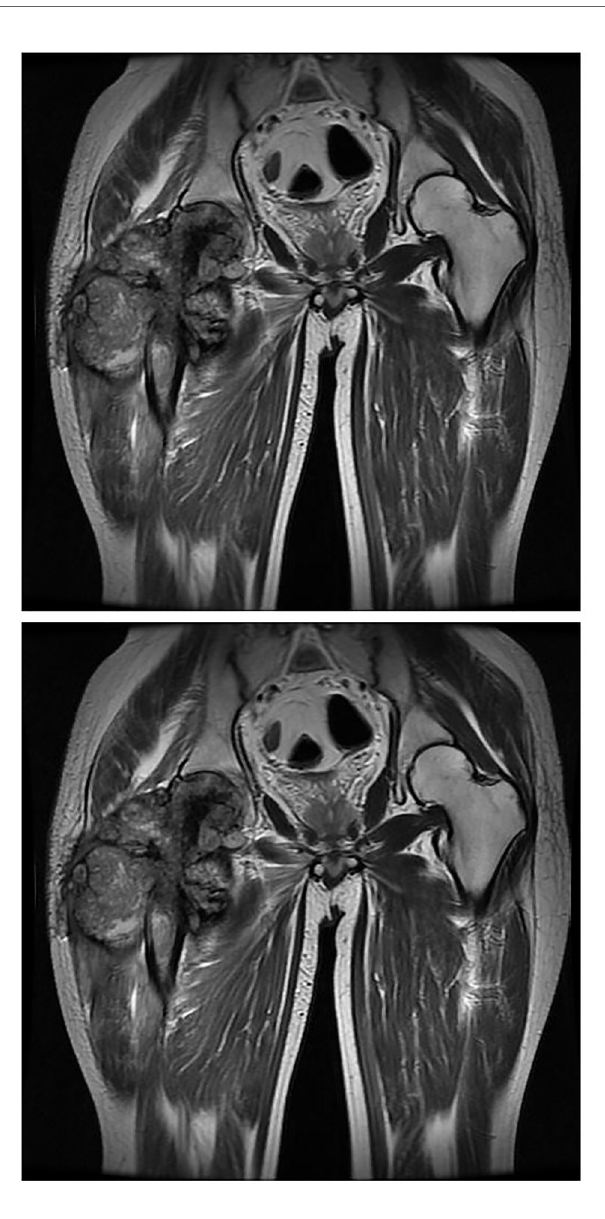
FIGURE 5 | MRI imaging at the fourth month of onset detected bone destruction and low intensity in T1WI while mixed intensity in T2WI mainly localized at the upper segment of femur. It is surrounded by cauli fl ower-like soft tissue mass with size of approximate 12.6 cm by 21.5 cm in great dimension. Jacent gluteus, iliopsoas, musculi obturator extemus and muscle group of right thigh acetabulum were